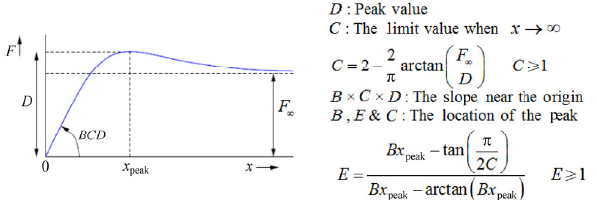
Fig. 13 Magic Formula’s